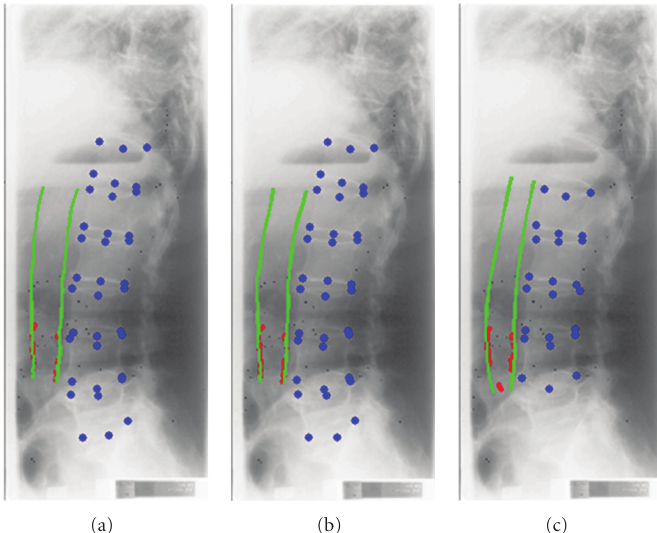
Figure 5: An X-ray of a participant in the EPI followup population. (a): an annotation by a radiologist. (b): a second annotation by the same radiologist. (c): an annotation done by another radiologist.